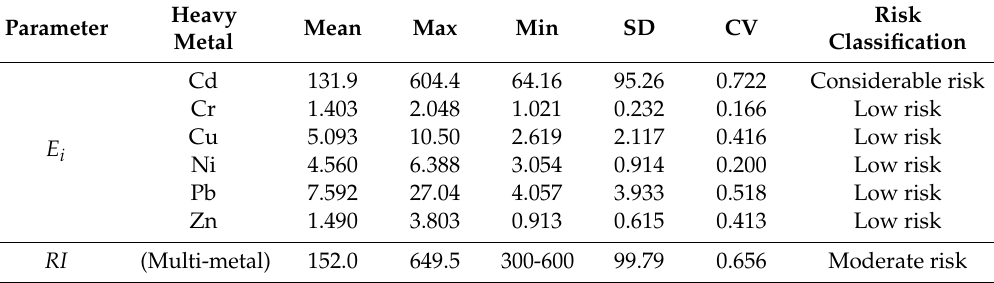
Table 7. Descriptive statistics of E i and RI for heavy metals in the study